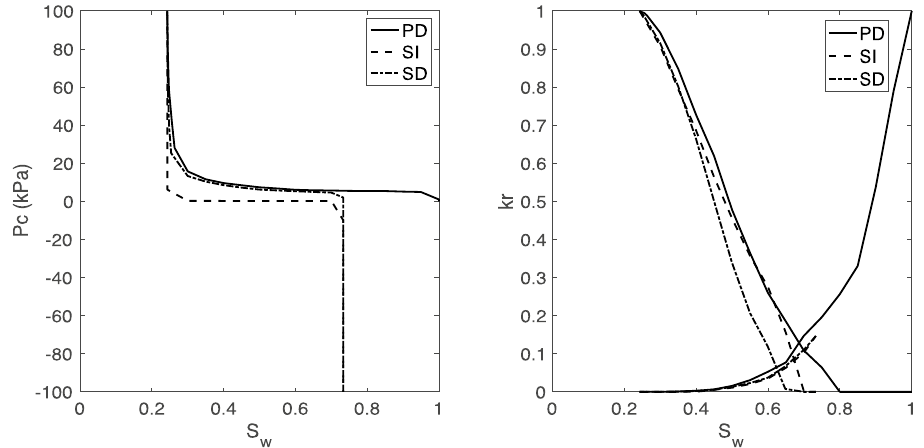
Figure 6. The impact of cyclic transport on capillary pressure and relative permeabilities for primary drainage (PD), secondary imbibition (SI), and secondary drainage (SD).